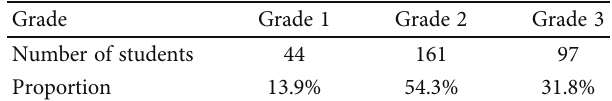
Table 2: Grade composition of surveyed students.